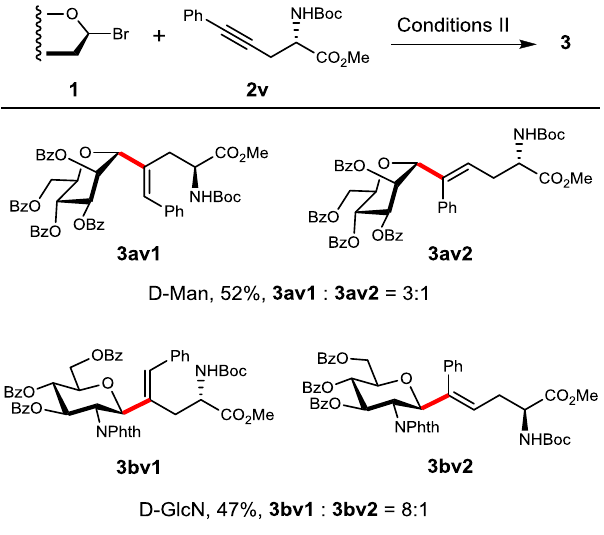
Fig. 6 C -Glycosylation with an internal acetylenic amino acid. In red are the formed C -glycosidic